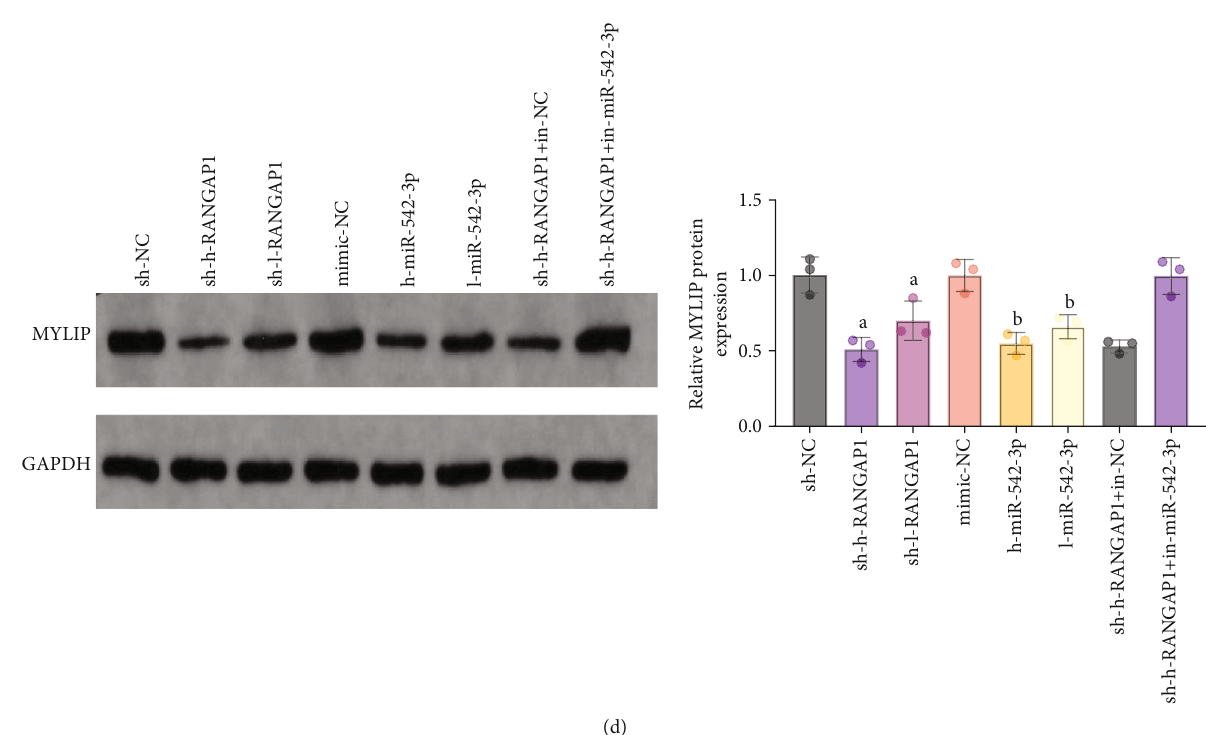
Figure 5: circ-RANGAP1, MYLIP, and miR-542-3p in each group. (a) circ-RANGAP1 in MG63 cells in each group. (b) miR-542-3p in MG63 cells in each group. (c) MYLIP in MG63 cells of each group. (d) MYLIP protein in MG63 cells of each group; The data in the fi gure were all measurement data in the form of mean ± SD . a represented P < 0 : 05 versus the sh-NC; b represented P < 0 : 05 versus the mimic-NC; c represented P < 0 : 05 versus the